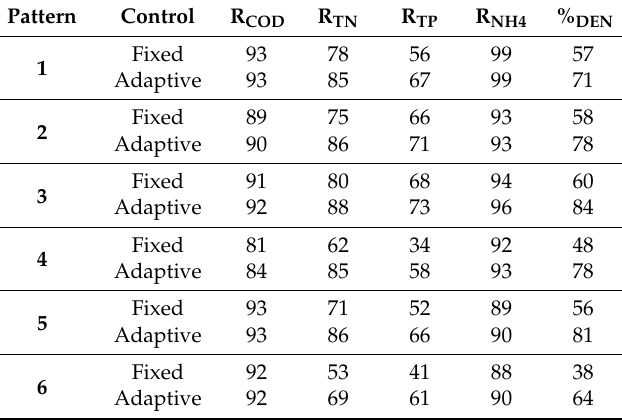
Table 3. Removal efficiencies, related to the each pattern, comparing the control with fixed thresholds (Fixed) and the multilevel adaptive control (Adaptive). Removal rates (in %): COD (R COD ),